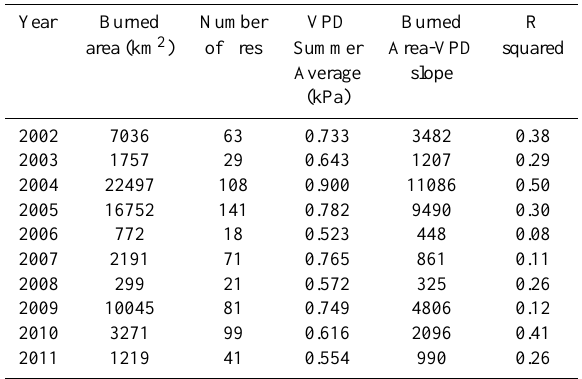
Table 2. Annual VPD summer average 1 (June–August), slope of the burned area-VPD relationship and r squared.